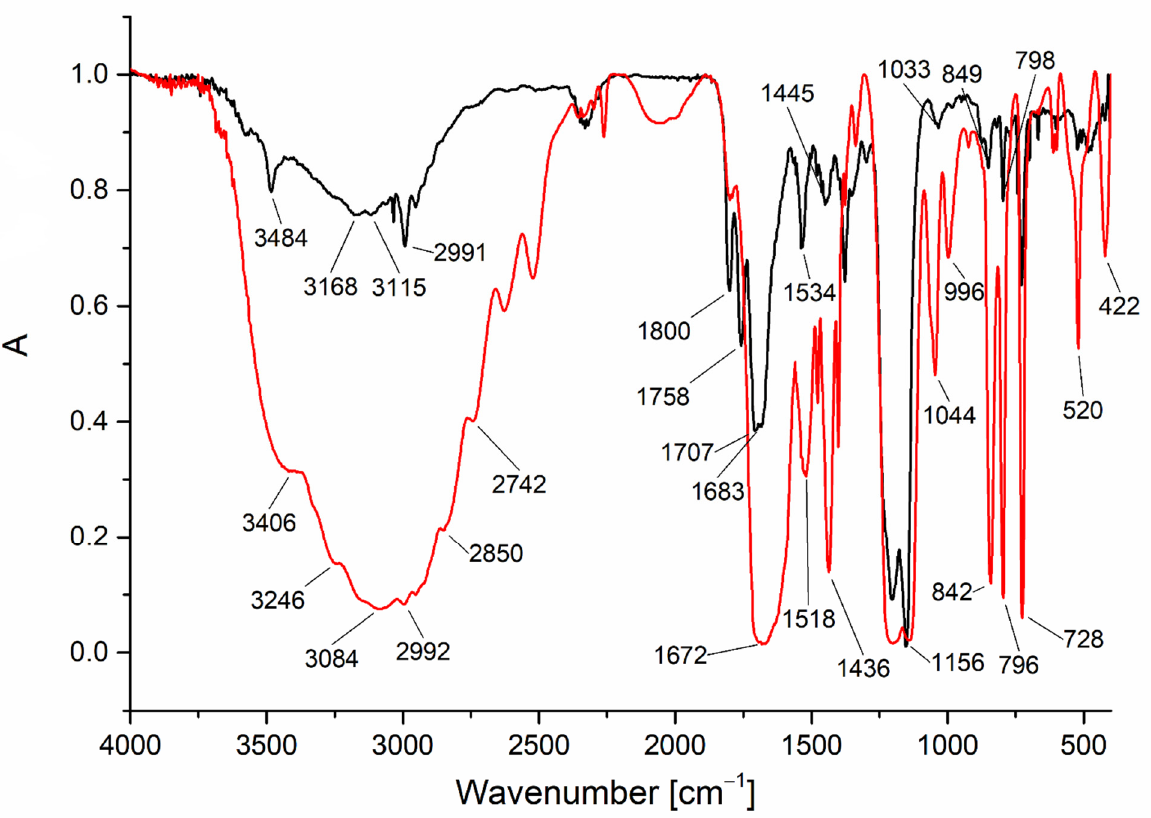
Figure 5. The spectra comparison for the [Cu 2 (EtNH 2 ) 2 ( µ -O 2 CCF 3 ) 4 ] complex ( 1 ) in the solid-state (red line) and the gas phase at 493 K (black line).